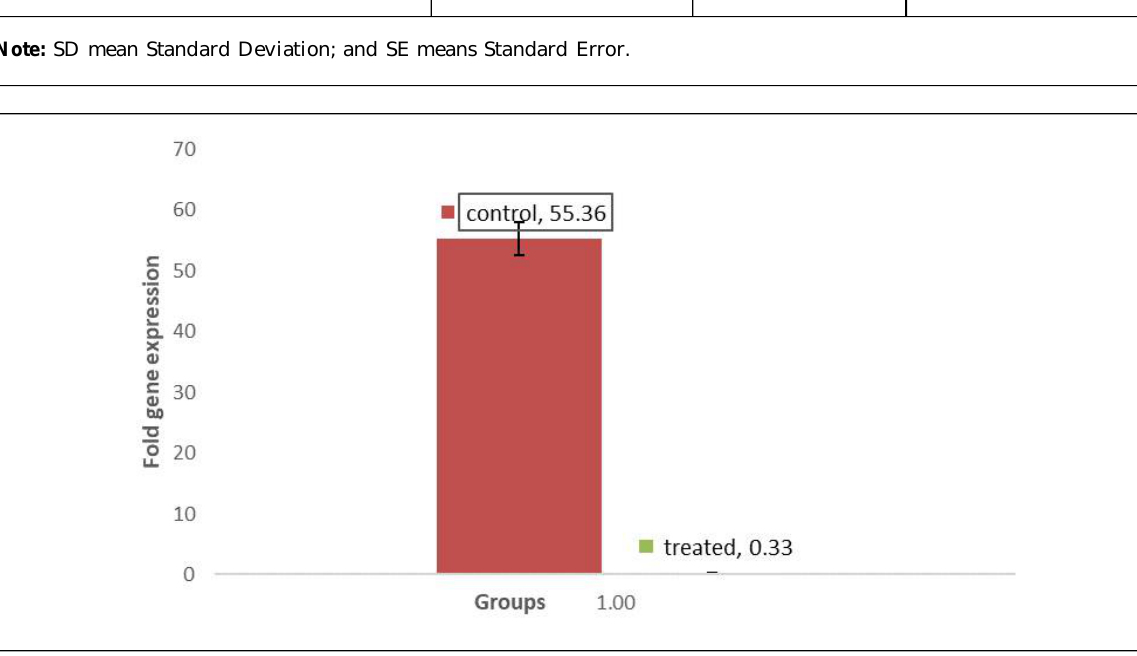
Figure 3: Fold gene expression level for control and treated group using LmcesA20